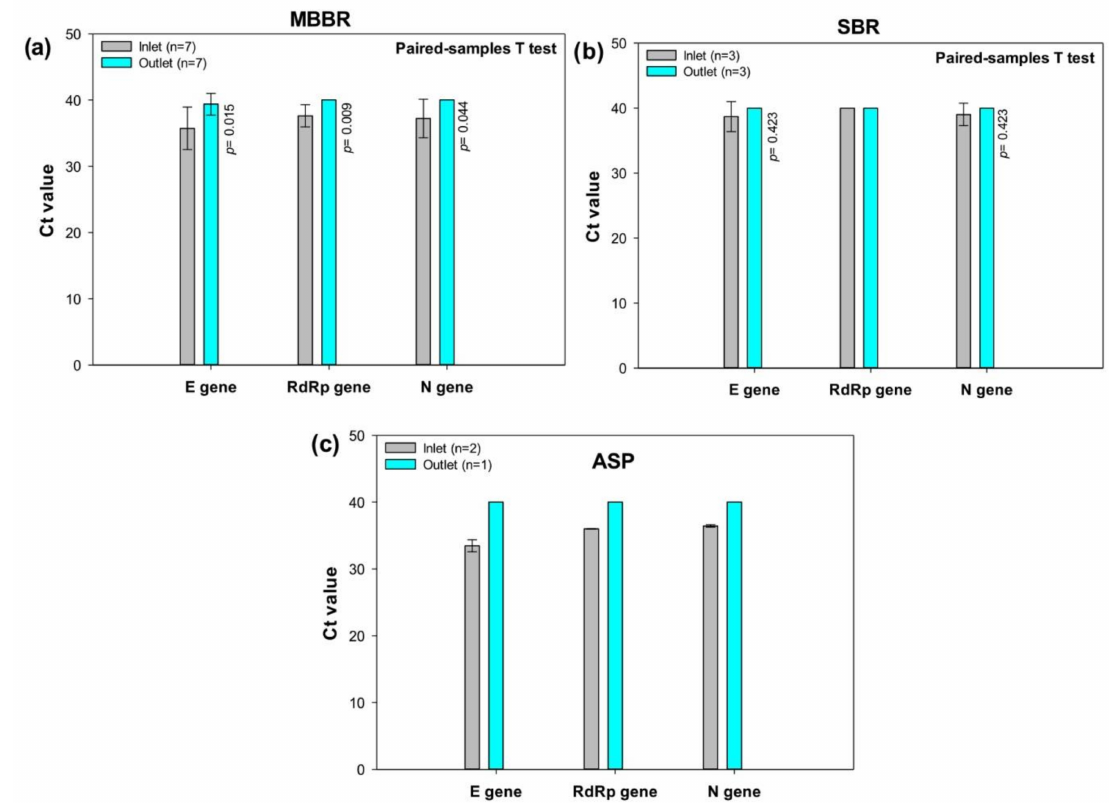
Figure 3. Comparison between the inlet and outlet wastewater samples for SARS-CoV-2 genetic load in ( a ) Moving bed Bioreactor (MBBR) based treatment; ( b ) Sequencing batch reactors (SBR); and ( c ) Activated Sludge Process (ASP).